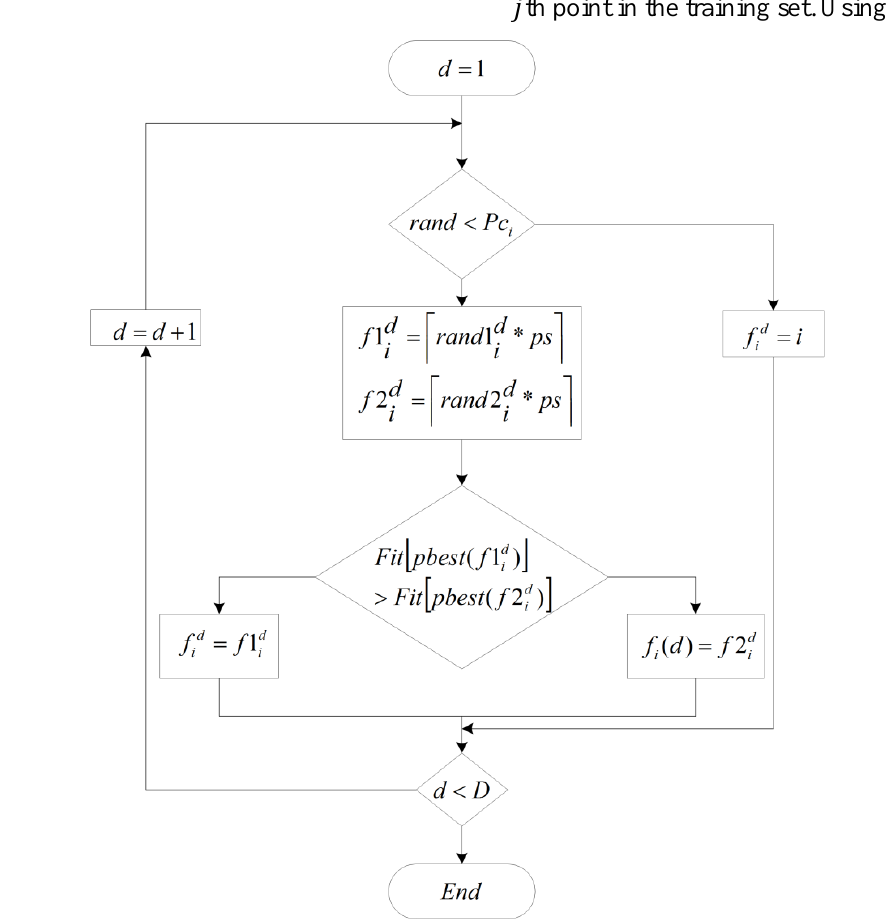
Figure 2. Selection of exemplar dimensions for particle